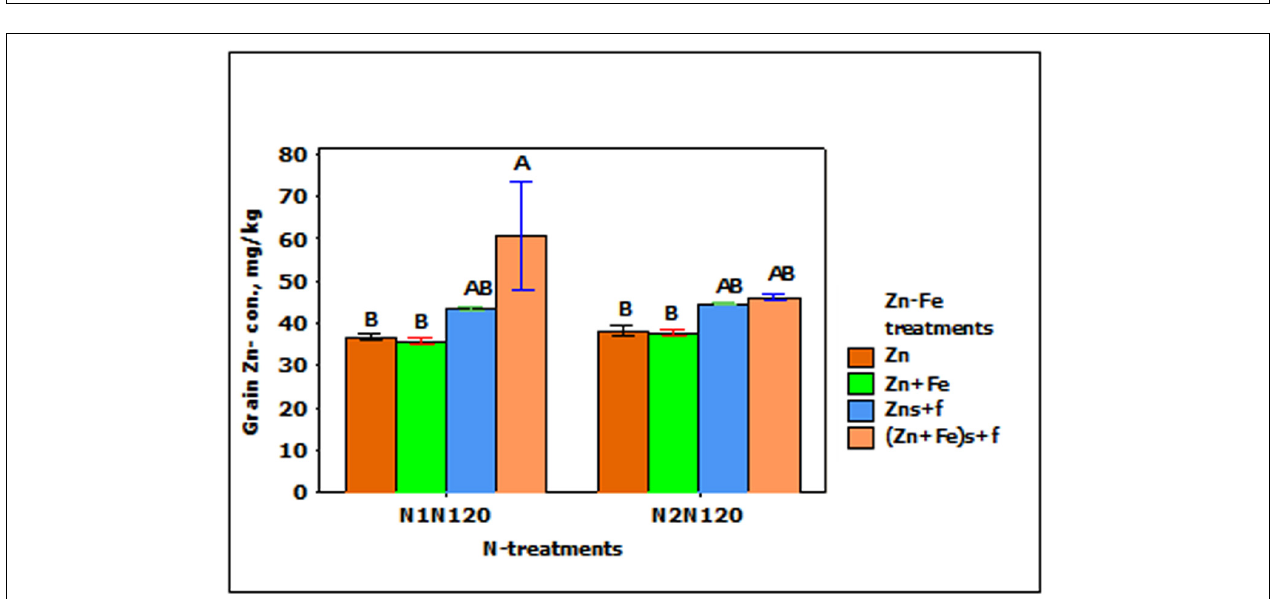
FIGURE 5 | Mean ± 1 SE ( n = 4) bar plot of grain Zn- concentration for the effect of Zn–Fe- treatments. N1 and N2, respectively stand for single and split application of N. N120 stands for 120 kg N ha − 1 . Zn and Zn + Fe without suffix for growth media application and with suffix s + f for growth media plus foliar application. Bars with same alphabet at head are not significantly different at 5% level of